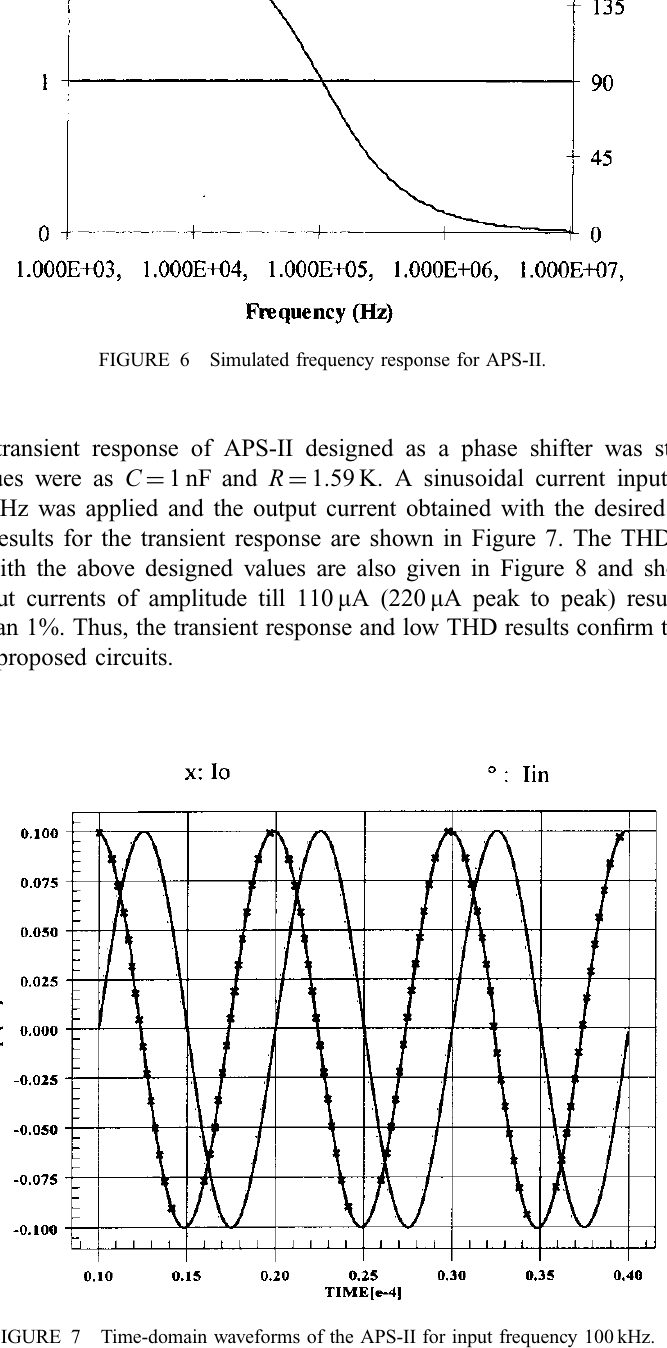
FIGURE 7 Time-domain waveforms of the APS-II for input frequency